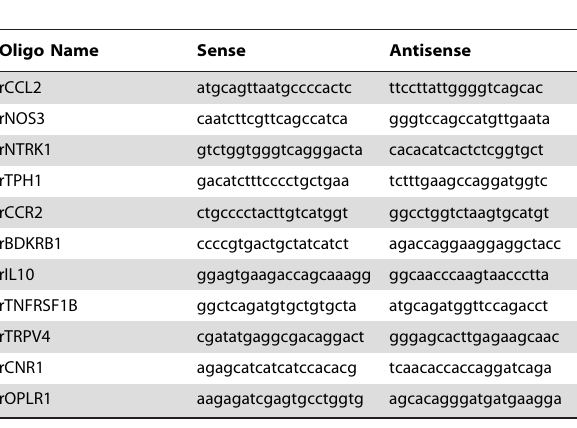
Table 2. Sense and antisense probes for genes related to ‘‘Pain’’